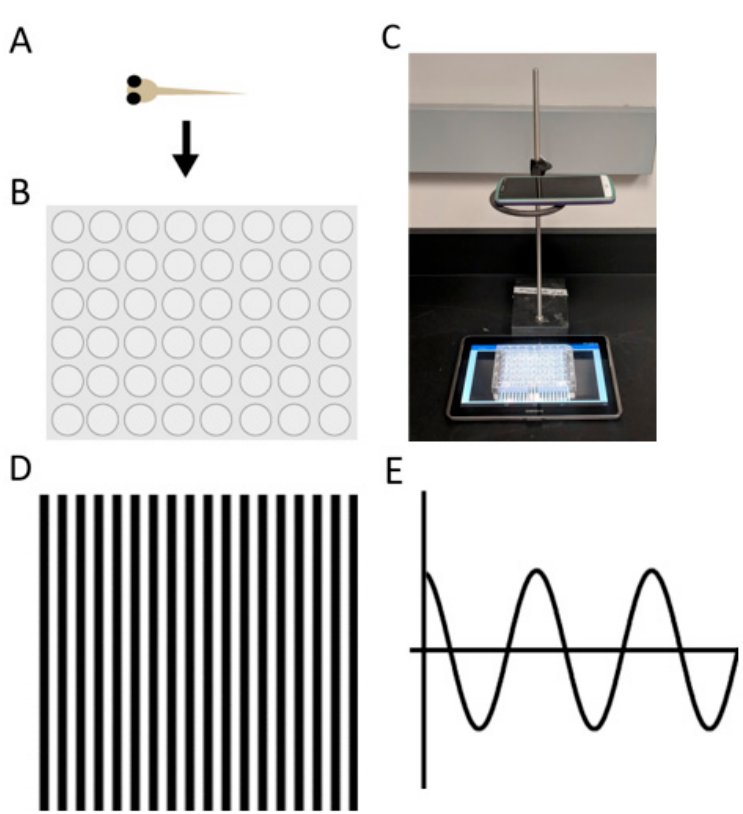
Figure 1. The OMR assay. ( A ) 6 days post-fertilization embryos are loaded individually into; ( B ) 48-well plates; ( C ) movement is captured with a cell phone camera on an O-ring positioned over the plate of fish on the tablet; ( D ) the tablet displays an image of black and white lines moving from right to left; ( E ) the embryos interpret the lines as sinusoidal waves and perceive this as motion.